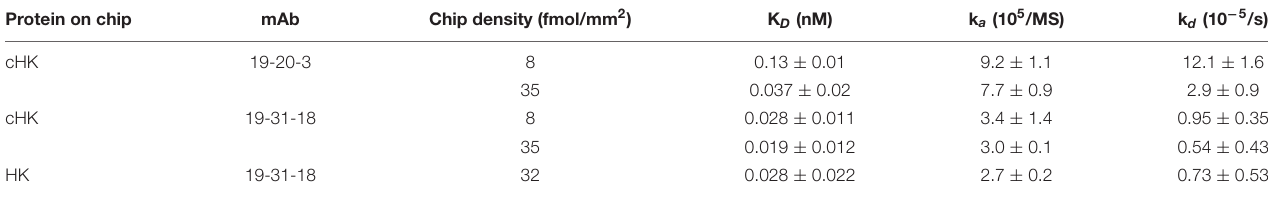
TABLE 2 | Binding parameters of the interactions between immobilized H-kininogen (HK) or cleaved HK (cHK) and monoclonal antibody (mAb) 19-20-3 or 19-31-18. Protein on chip